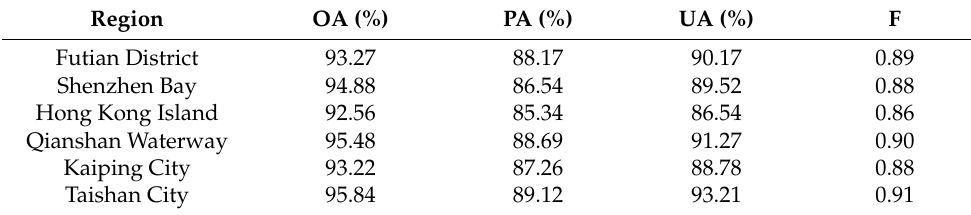
Figure 10. BAs extraction results of our proposed method for the second Sentinel-1 SAR image. The first row denotes the BAs extraction results of the whole SAR image, which are shown in red. ( a1 – a4 ) Original SAR images of the four selected areas from the whole image. ( b1 – b4 ) The corresponding binary BAs extraction map. Table 3. BAs extraction accuracy of the six areas in Figure 9 using our